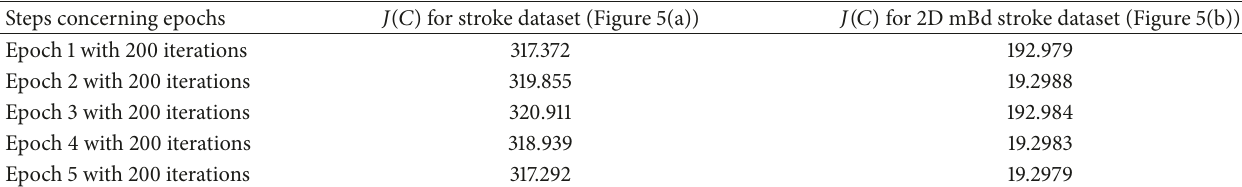
Table 5: Result of 𝐾 -means algorithm clustering for 1000 iterations (as obtained from Figure 5).